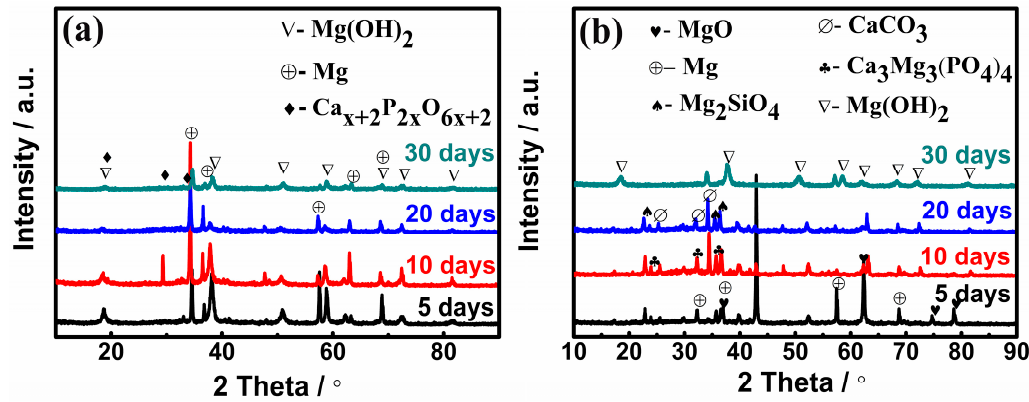
Figure 7. XRD patterns of ( a ) the uncoated and ( b ) the MAO coated samples after immersion for 30 days.